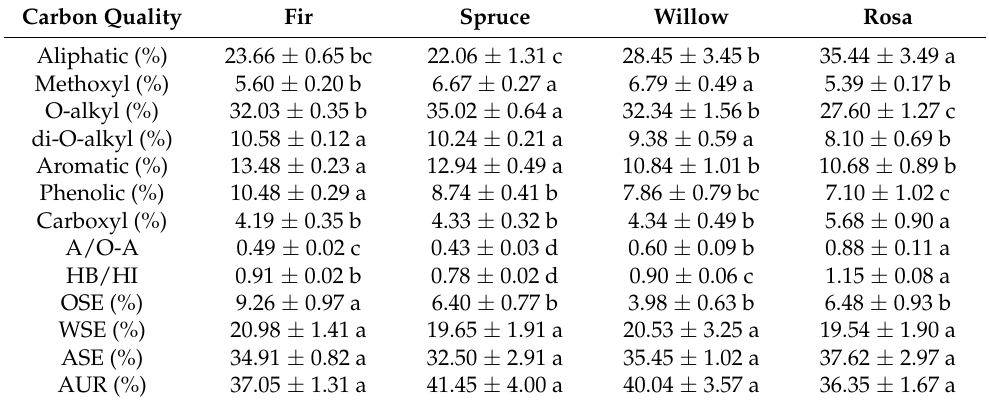
Table 1. Properties of the C quality of newly shed foliar litter for each plant species. Different lowercase letters indicate significant ( p < 0.05) differences among the various plant species for each C quality aspect (plant species: fir, spruce, willow and rosa; functional C groups: aliphatic C, methoxyl C, O-alkyl C, di-O-alkyl C, aromatic C, phenolic C and carboxyl C; organic components: WSE, water-soluble extractives, OSE, organic-soluble extractives, ASE, acid-soluble extractives, AUR, acid- unhydrolyzable residues; HB/HI, (0–45 ppm + 110–165 ppm)/(45–110 ppm + 165–190 ppm), and A/O-A, aliphatic C/O-alkyl C)). Carbon Quality Fir Spruce Willow Rosa